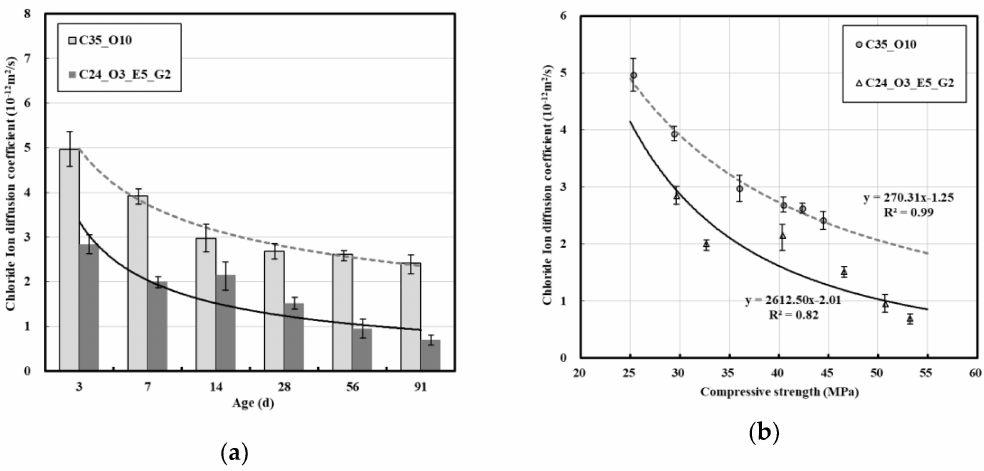
Figure 10. ( a ) Chloride ion di ff usion coe ffi cient with age; ( b ) relation between compressive strength and chloride ion di ff usion coe ffi